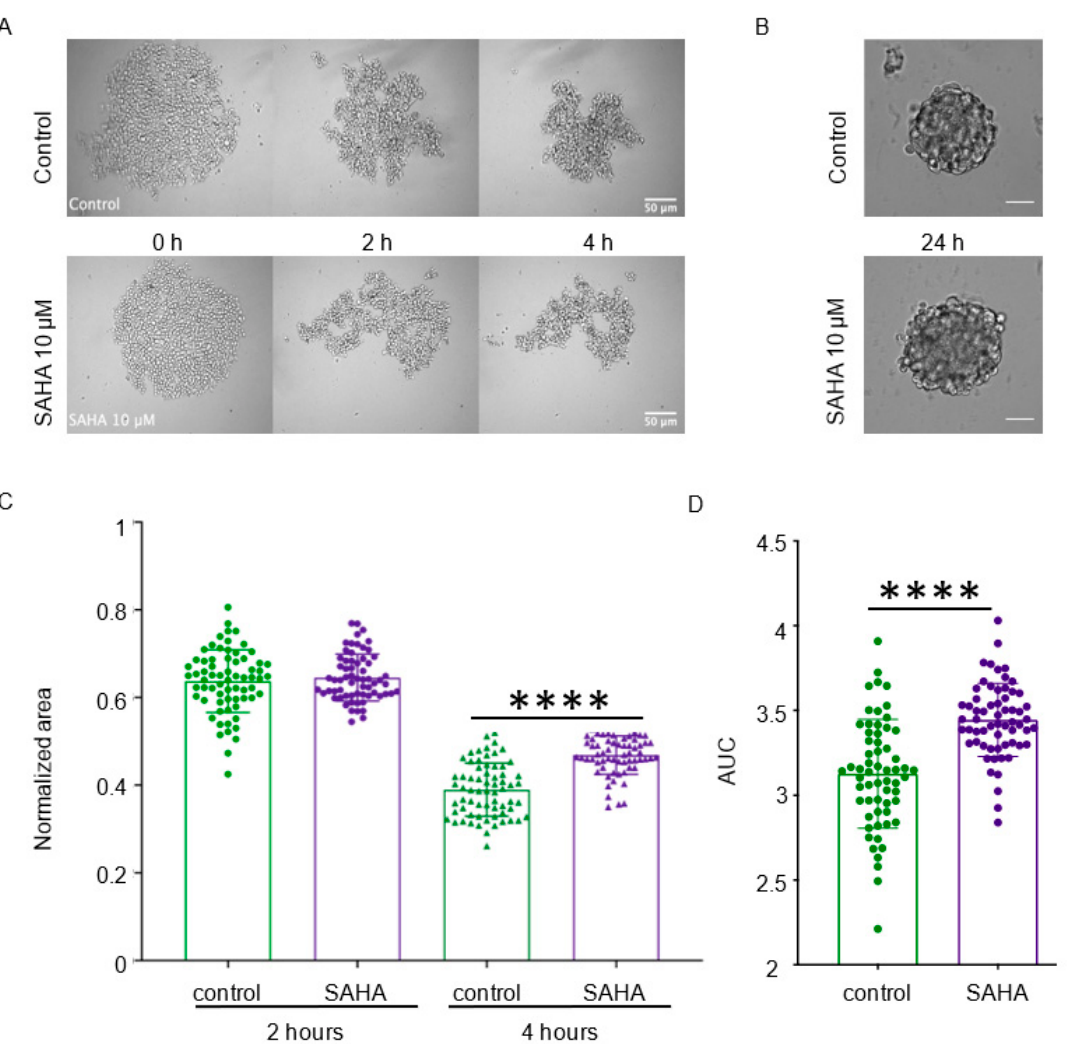
Figure 4. The HDAC inhibitor vorinostat impairs the early steps of cell clustering. ( A ) MCF-7 cells were incubated with 10 µ M of SAHA (vorinostat) or not (control) for 24 h and then their aggregation capacity was tested. Micrographs at the indicated time points during the aggregation assay are shown. ( B ) Micrographs of the aggregates formed after 24 h of incubation with or without SAHA. ( C ) The normalized area of cell aggregates in the presence or not of SAHA (10 µ M) was measured at 2 h and 4 h after initiation of the aggregation assay. Each dot corresponds to one replicate and bars are the mean ± SD ( n = 4 independent experiments). ( D ) AUC of cell aggregates in the presence or not of SAHA (10 µ M) after 6 h of aggregation. Data are the mean ± SD. Control n = 61 aggregates, SAHA n = 62 from four independent experiments. ****, p < 0.0001 (Mann–Whitney non-parametric